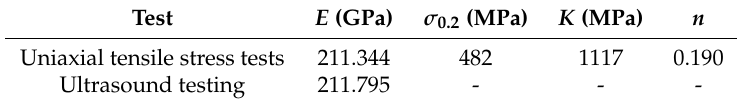
Table 1. Mechanical properties of the AISI 1038 alloy considered in the